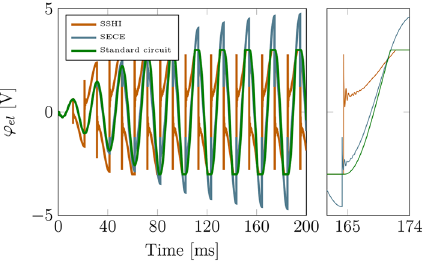
Fig. 8 Electrode voltage 𝜑 el of the bimorph PVEH with standard, SSHI and SECE circuit under a harmonic base acceleration of 0.5 m/ s 2 and a frequency of 48.7 Hz